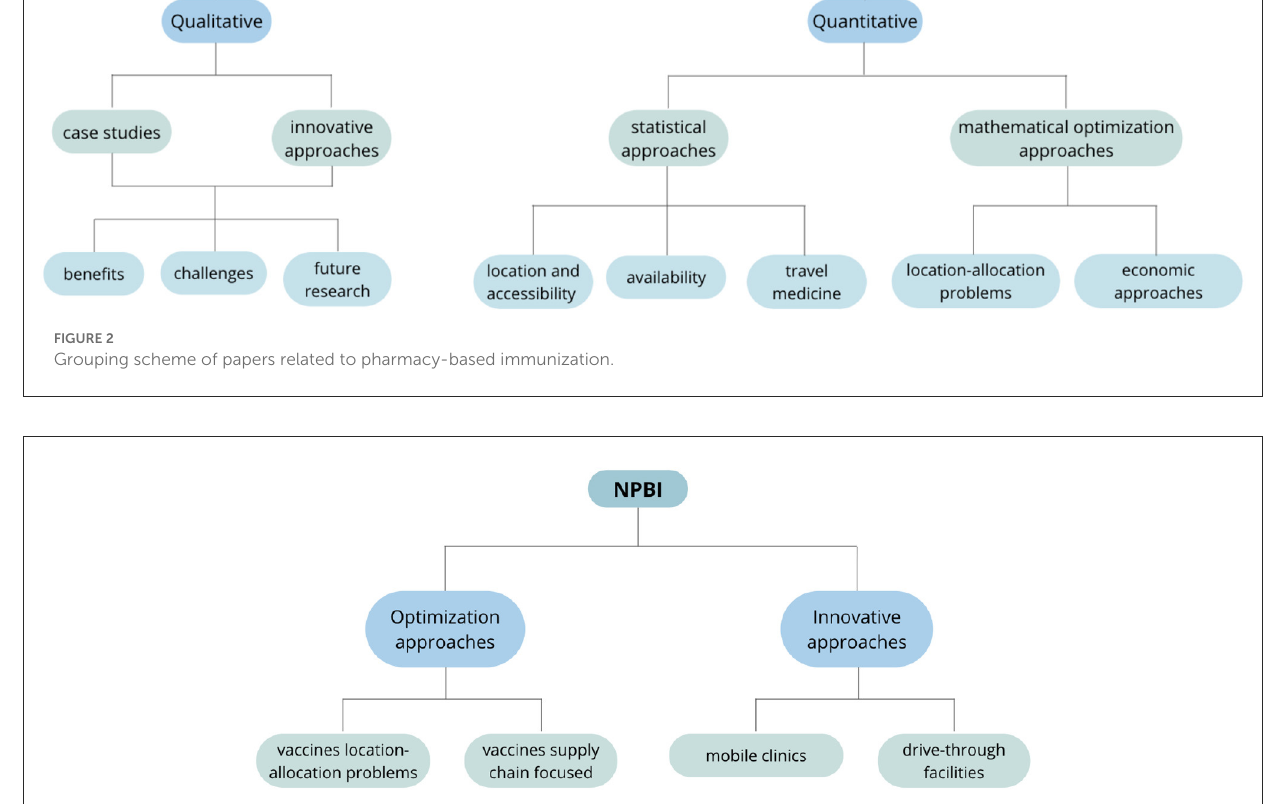
FIGURE3 Grouping scheme of non-pharmacy-based immunization related